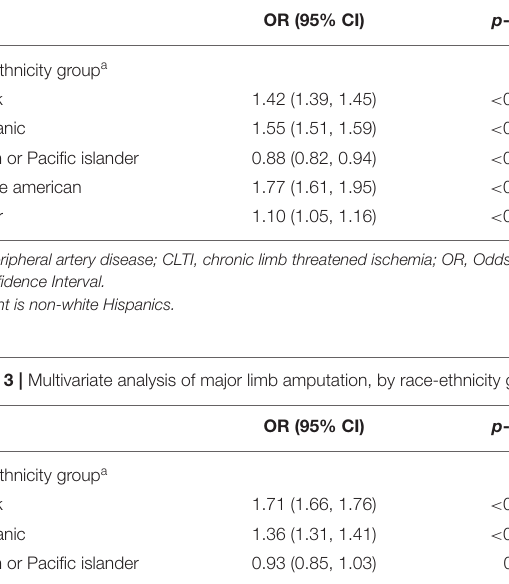
TABLE 2 | Multivariate analysis of PAD with CLI, by race-ethnicity group.